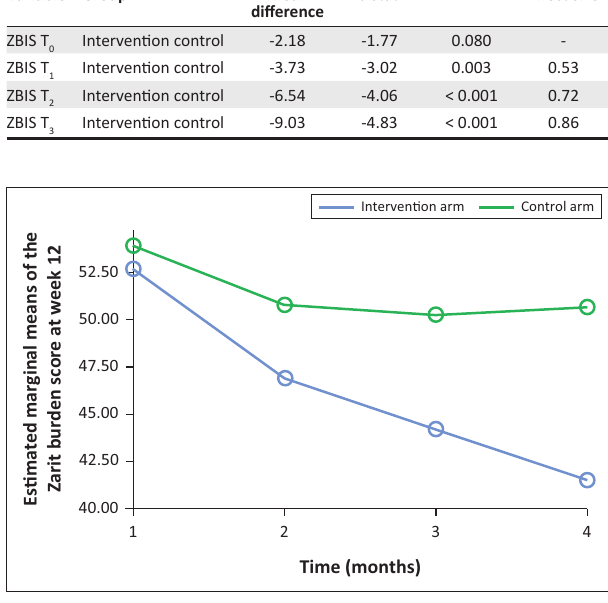
FIGURE 1: The effect of structured psychoeducation intervention and standard care on the caregiver participants’ burden of caregiving.